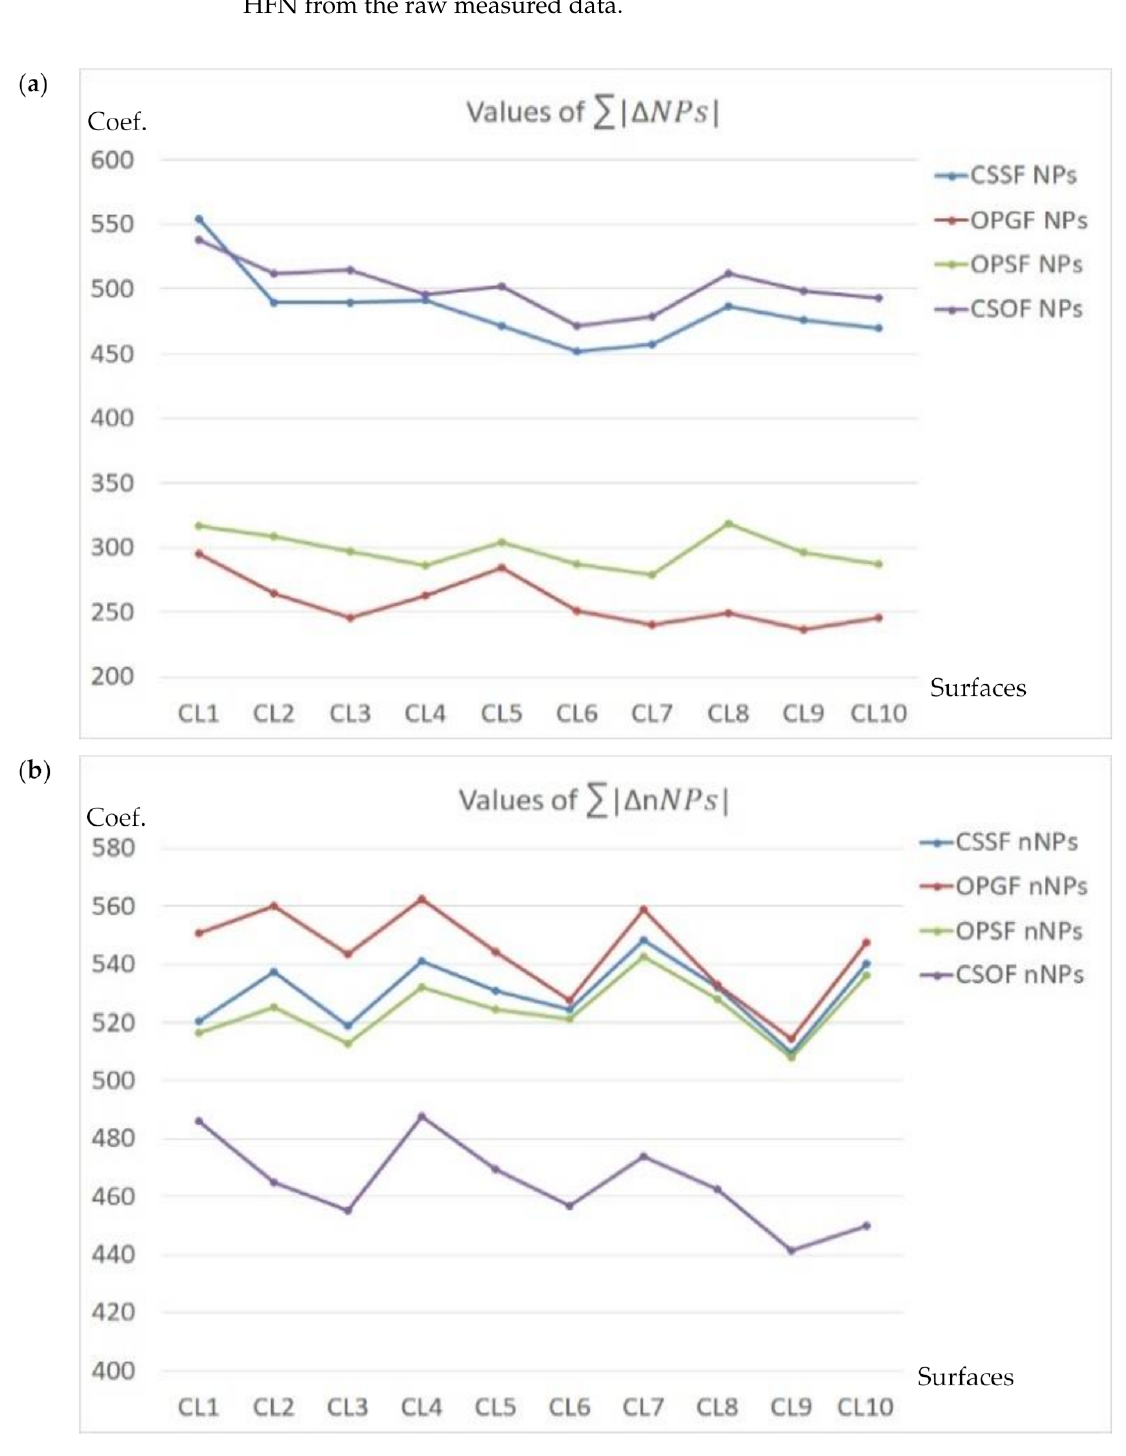
Figure 17. The values (presented in Coef. axis) of sums of NPs ( a ) and nNPs ( b ), described for plateau-honed cylinder liner